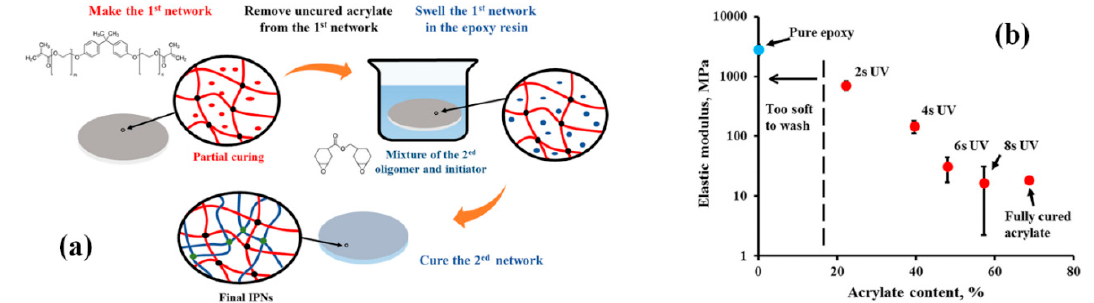
Figure 9. ( a ) Schematic representation of synthesis procedure of sequential acrylate/epoxy IPN, ( b ) elastic modulus as a function of acrylate content for sequential acrylate/epoxy IPN. Reprinted with permission from ref. [65], Copyright [2019], John Wiley and Sons.